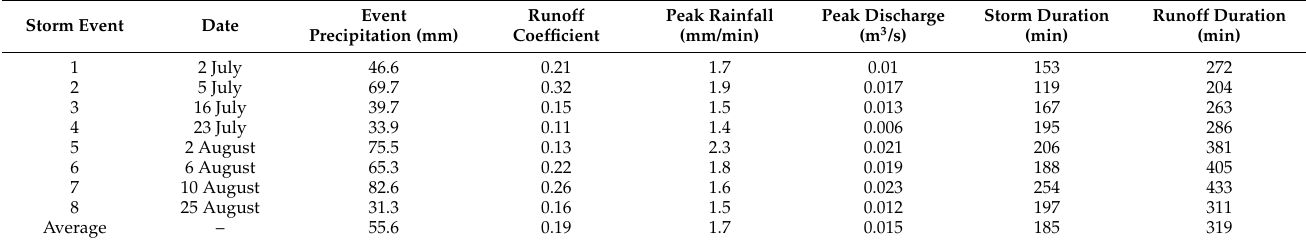
Table 2. Summary of the eight selected storm rainfall–runoff